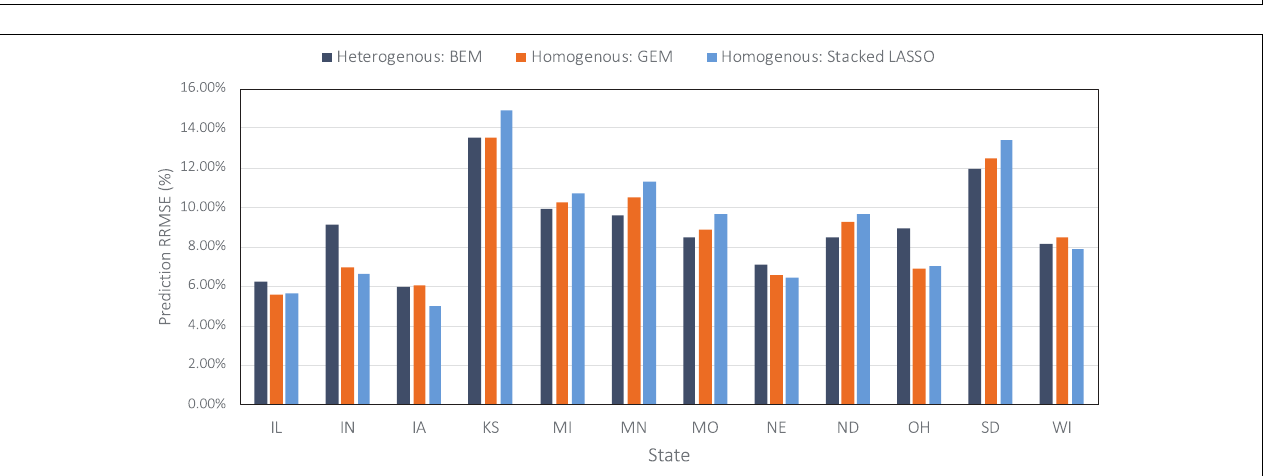
FIGURE 6 | Comparing prediction error (relative RMSE) of some of the designed ensembles across all US Corn Belt states on the data from the year 2019 taken as the test data.